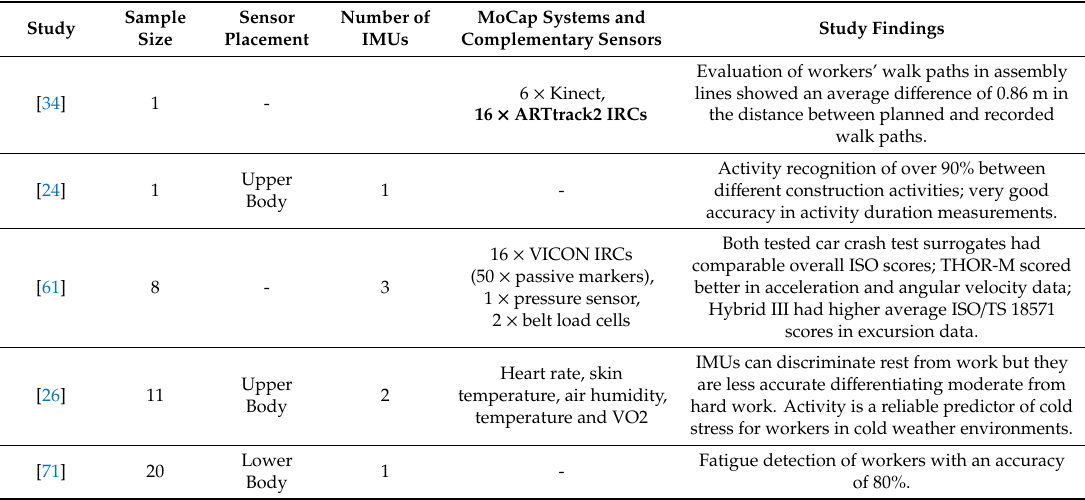
Table 8. Summary of study designs and